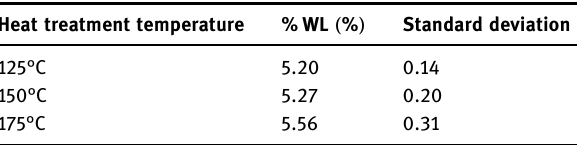
Table 1: Averages of % WL of MCC powder at di ff erent heat treat - ment temperatures, n = 5